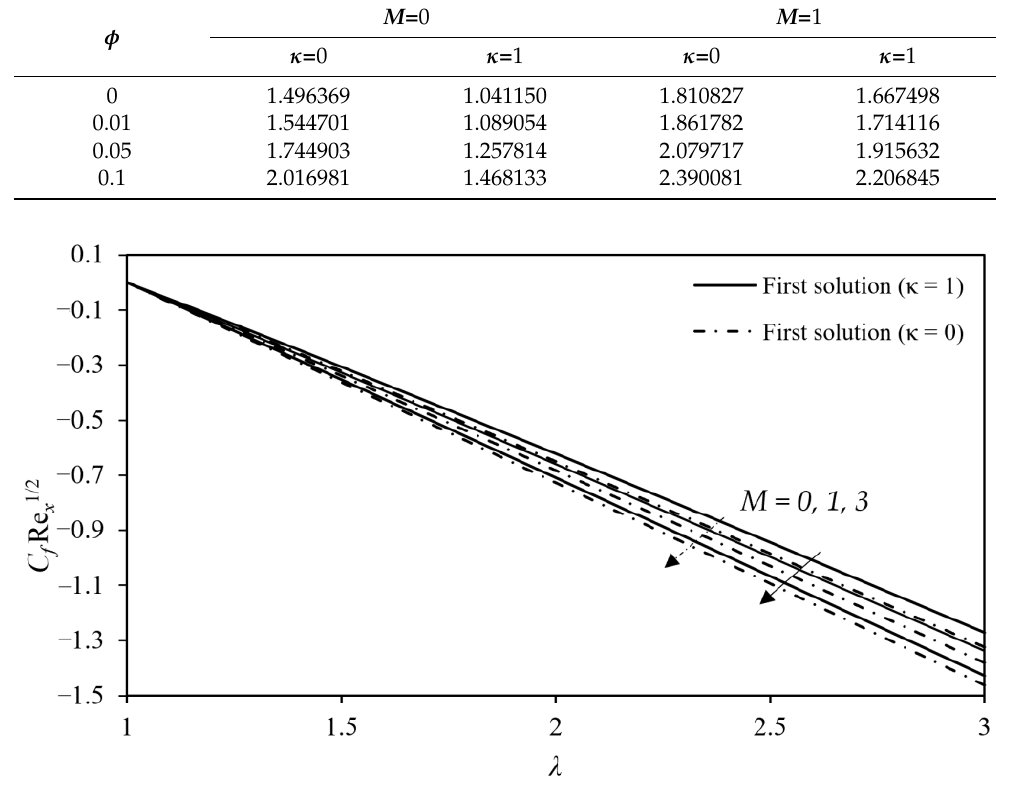
Figure 4. The behaviour of C f Re 1/2 x towards the stretching parameter, λ , for different M and κ when φ = 0.01, A = 1, and δ = 1.